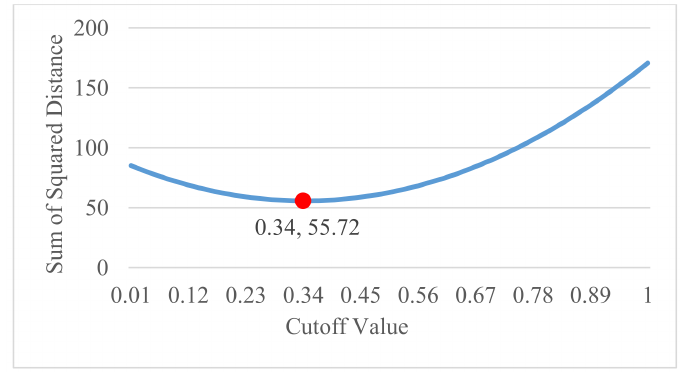
Figure 3. Cutoff value